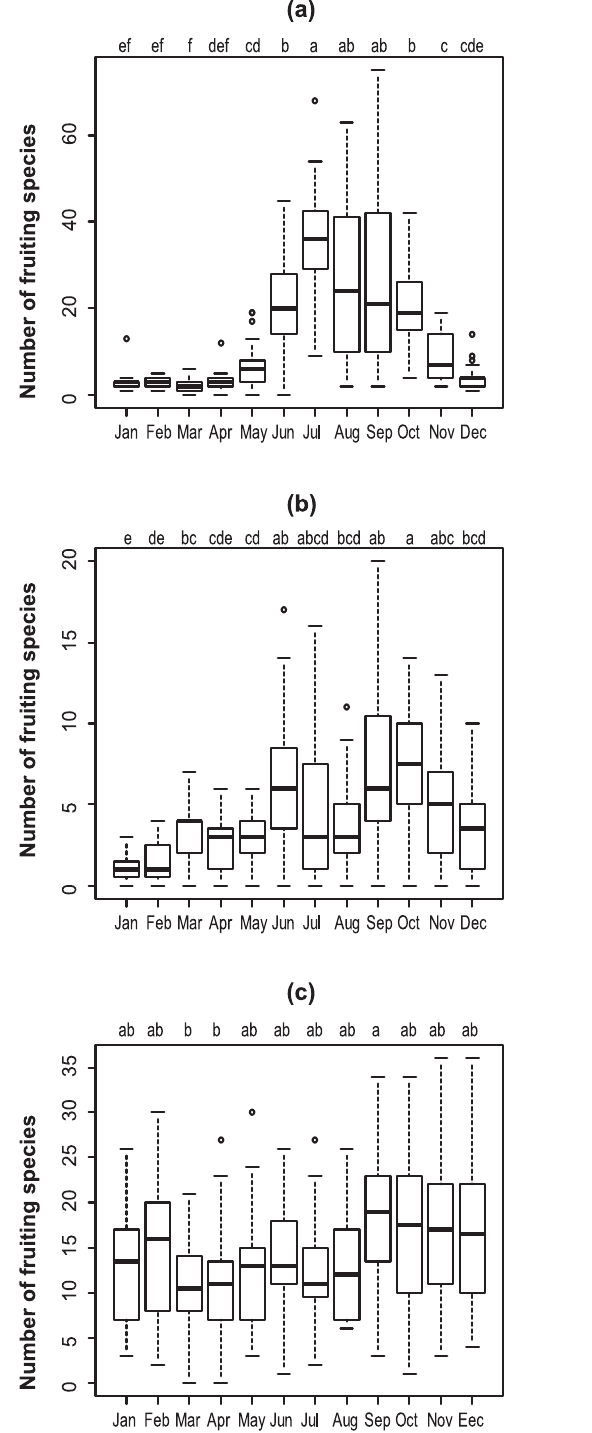
Figure 2. Monthly change in number of fruiting species for ectomycorrhizal fungi (a), litter-decomposing (b), and wood- decomposing fungi (c). Different letters indicate a significant difference at P , 0.05 (Steel–Dwass test).